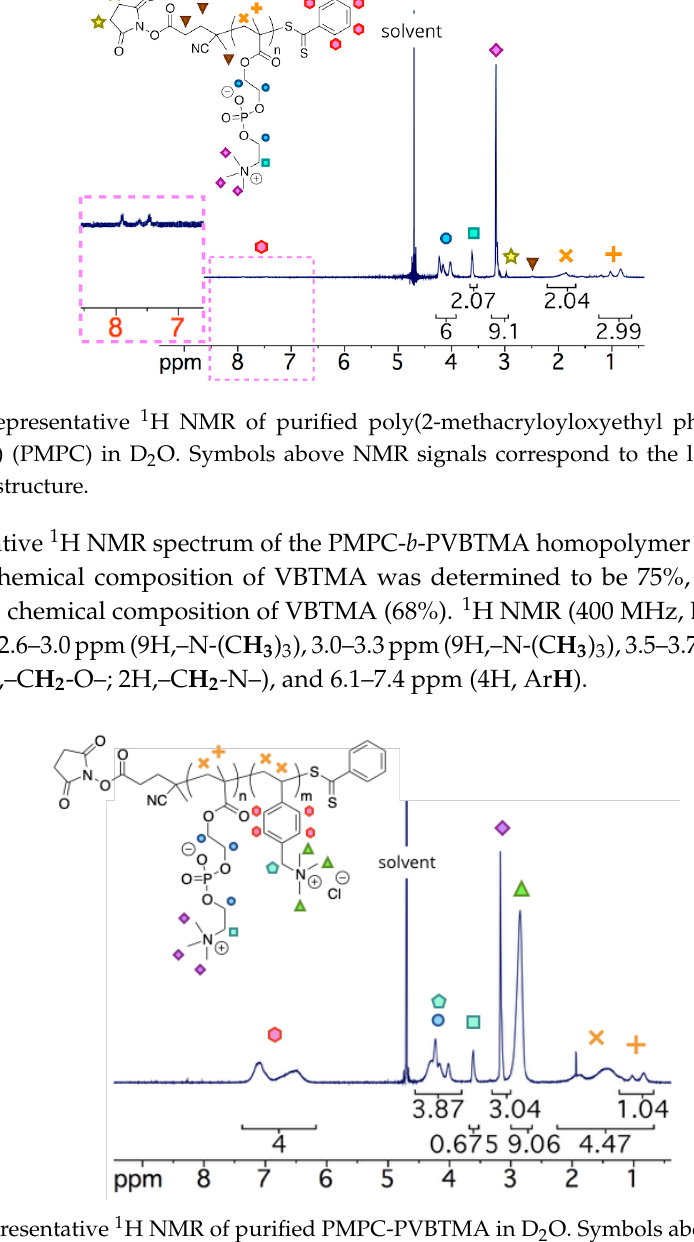
Figure 3. Representative 1 H NMR of purified PMPC-PVBTMA in D 2 O. Symbols above NMR signals correspond to the labeled atoms on the chemical structure.